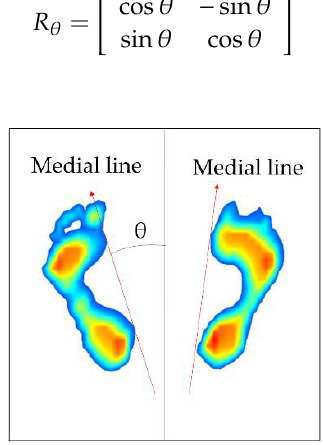
Figure 6. Definition of rotation angle.